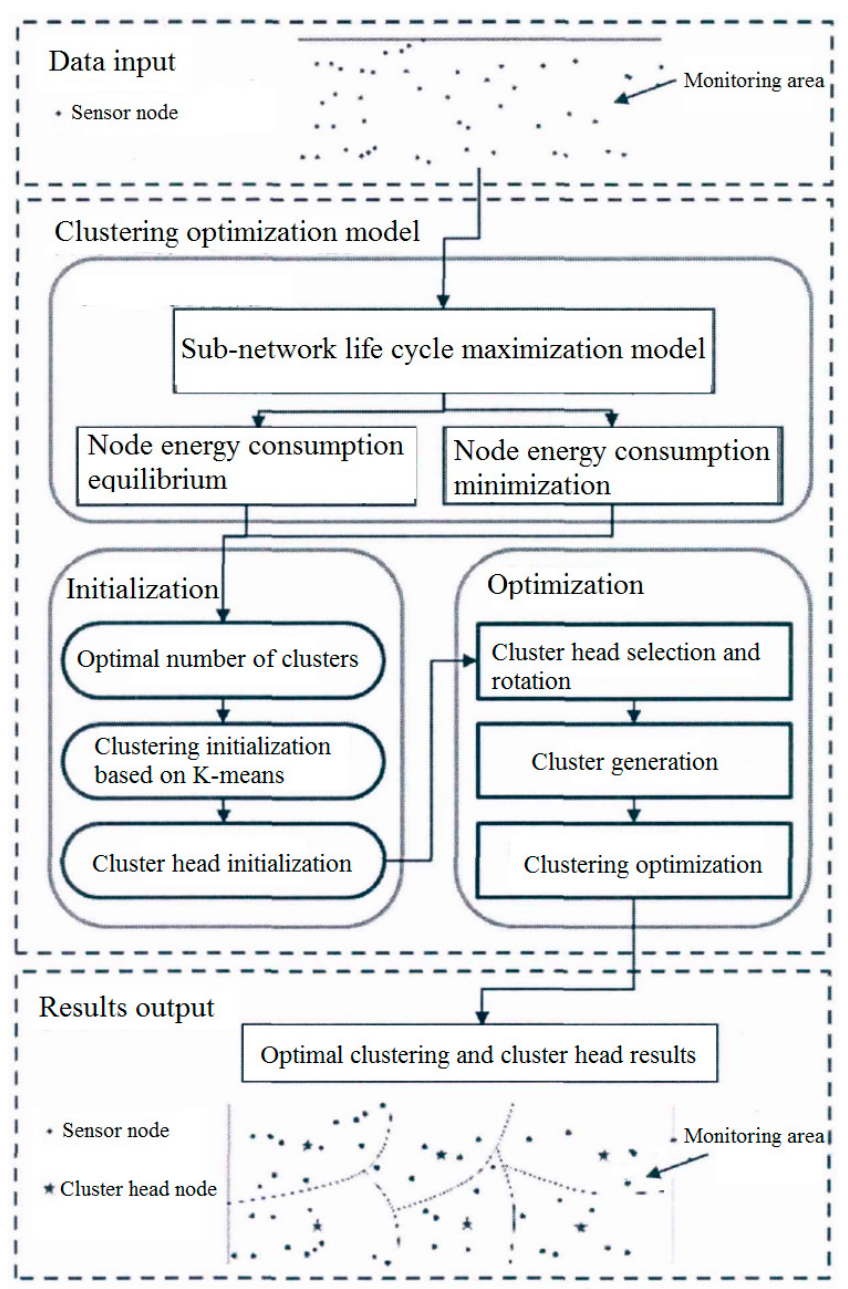
Figure 4. Structure of cluster-based energy optimization routing protocol for sub-network.